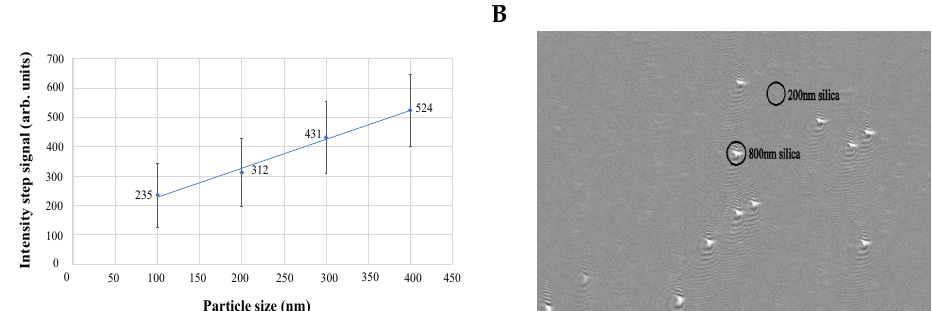
Figure 13. ( A ) dependency of the value of the intensity changes (“step” signal) from the size of nanoparticles; for these measurements, polystyrene particles of sizes 100nm, 200nm, 300nm, and 400nm were used; three independent experiments were performed; ( B ) 800nm and 200nm silica particles were detected simultaneously by the modified SPR microscopy sensor; the black circles mark the particle binding signals. Adapted from